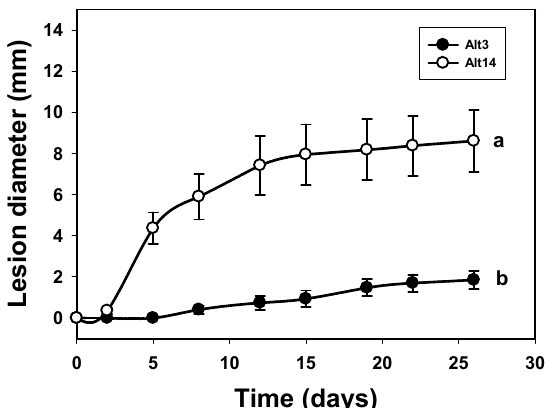
Figure 1. Development of lesions caused by two A. alternata isolates in unwounded fruits of ‘Fortune’ mandarin: Alt3 ( ) and Alt14 ( ). The data represent mean values of lesion diameter (mm) at different days post-inoculation. Vertical bars denote ± SE ( n = 3) when larger than symbols. Values not sharing a common superscript letter are significantly different ( P < 0.05).